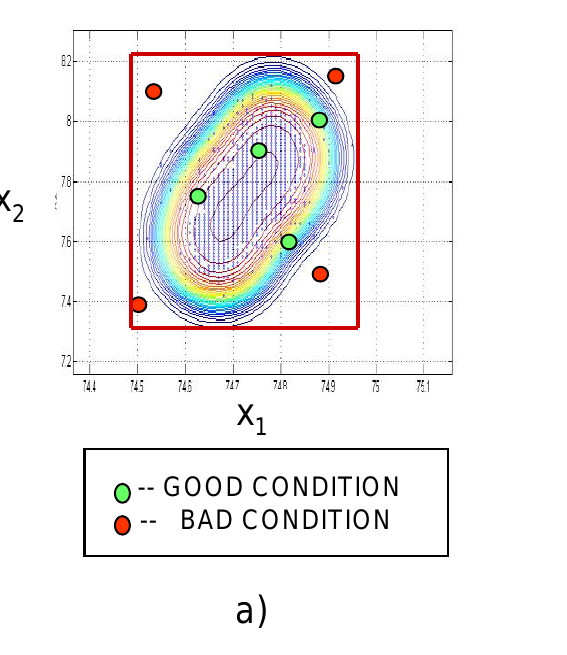
Figure 8. ( a ) Example of the Neural Clouds application to 2-D data. ( b ) 3-D presentation of the confidence values: value close to 1 is related to a normal behaviour, values close 0 can be interpreted as